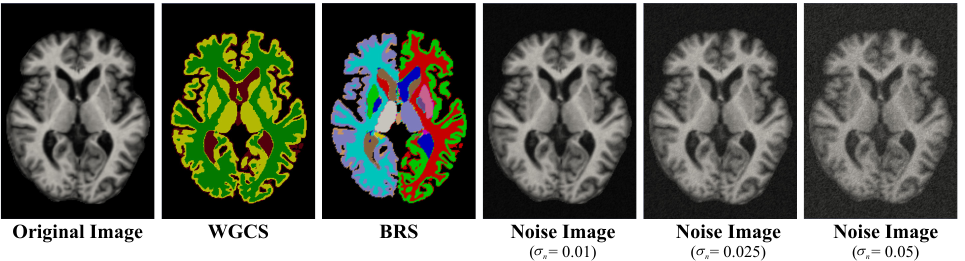
Figure 5. The axial view of both #161 in the OASIS-1 dataset and noise images are shown. The first image is the original skull-stripped image of #161, the second image is the related WGCS, and the third image is the BRS of 35 regions. The last three images display the noise images of the standard deviation σ n = 0.01, 0.025, 0.05,